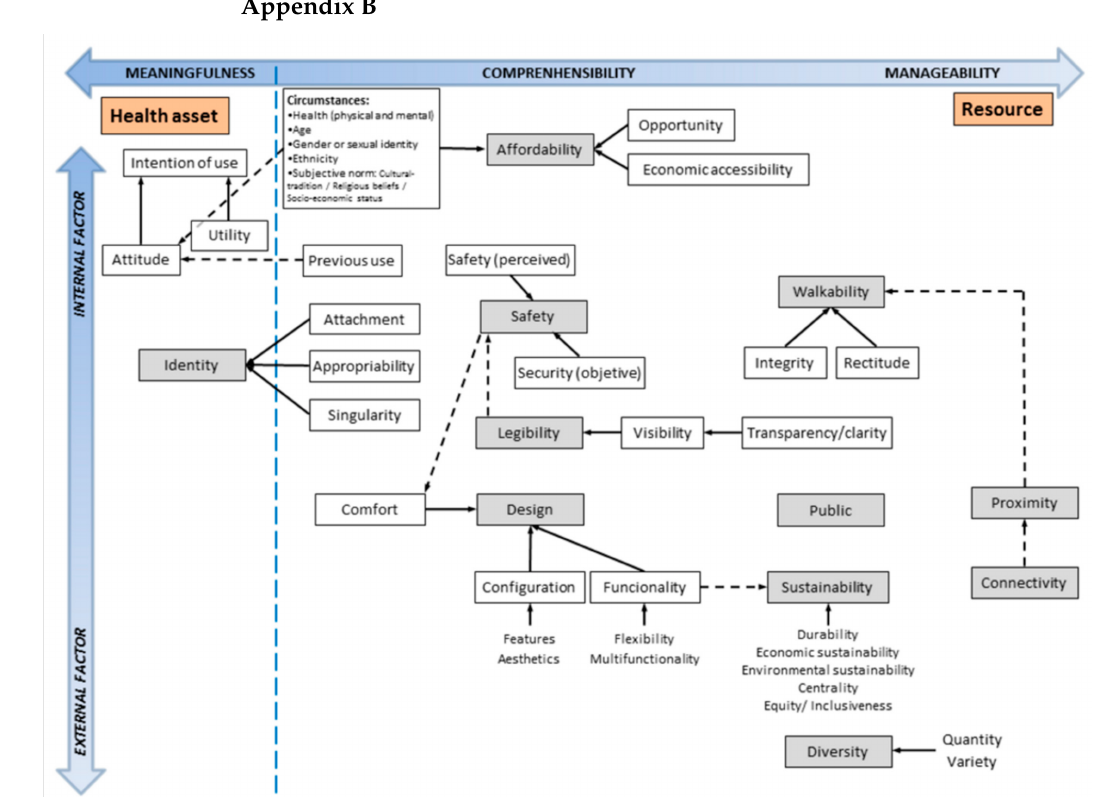
Figure A1. Model for the Evaluation of Community Assets for Health, interrelation of the dimensions and